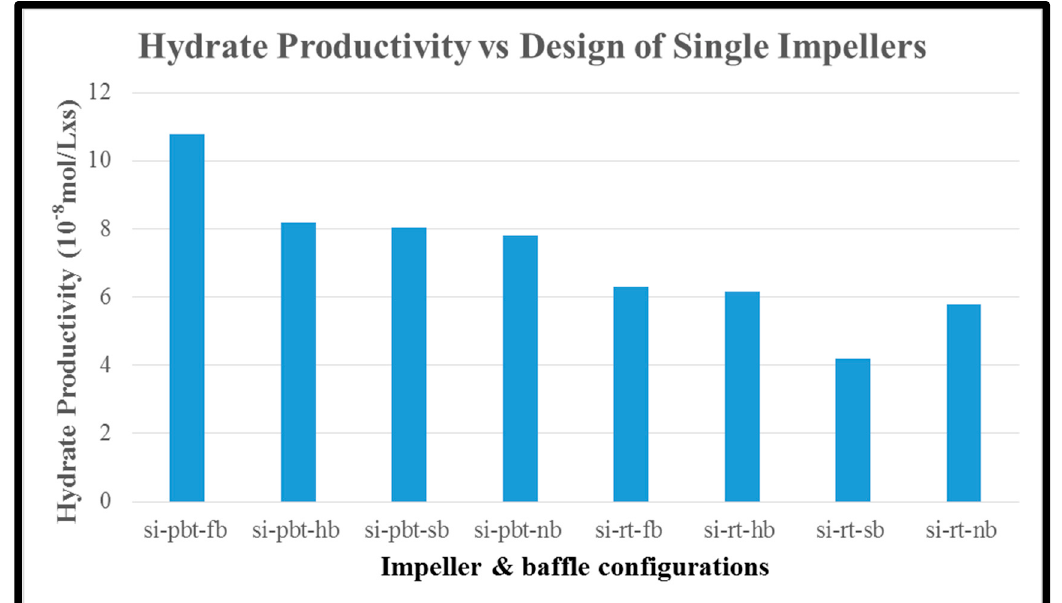
Figure 11. Hydrate productivity of single impeller experiments.